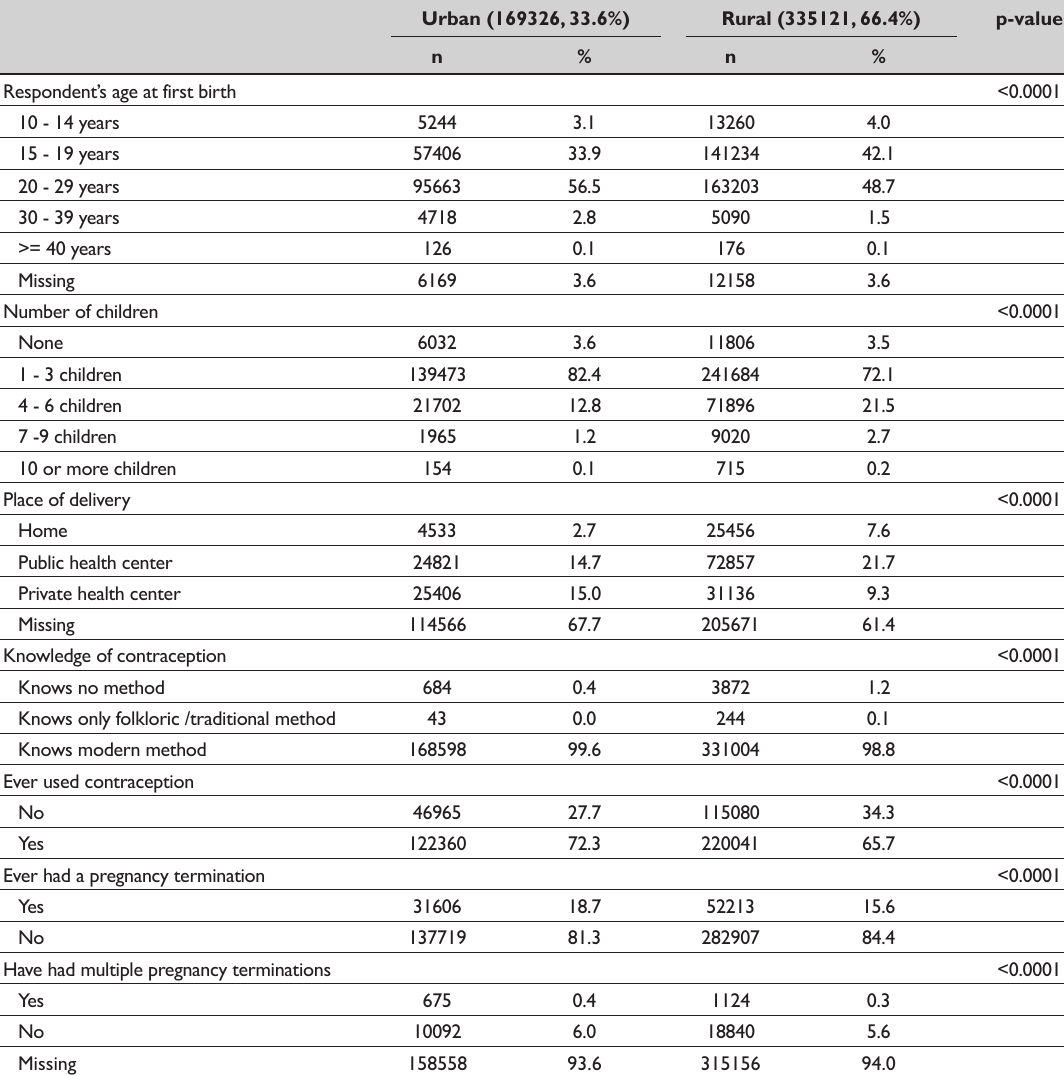
Table 2: Pregnancy characteristics of women stratified by place of